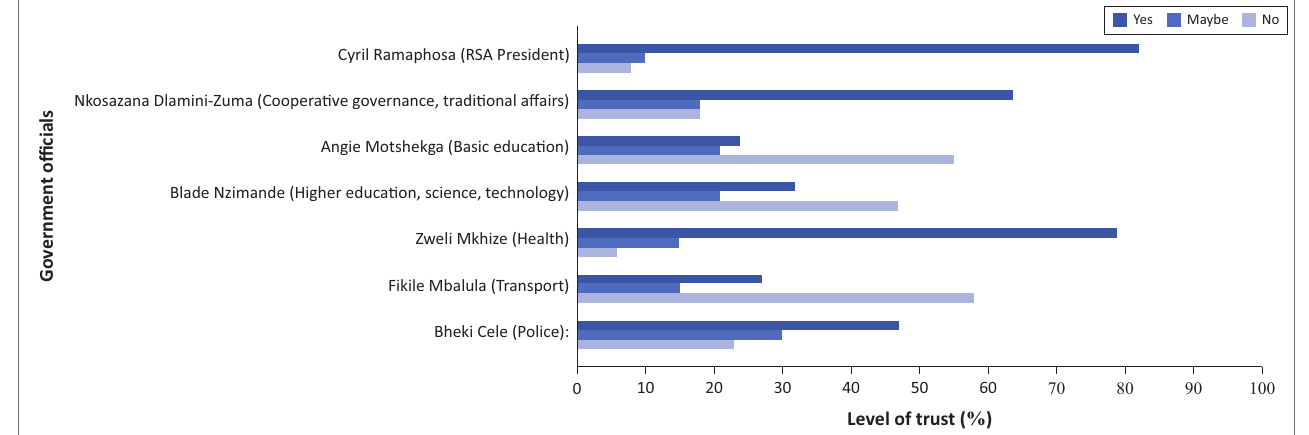
FIGURE 5: Trust in the government officials when communicating about coronavirus disease 2019.